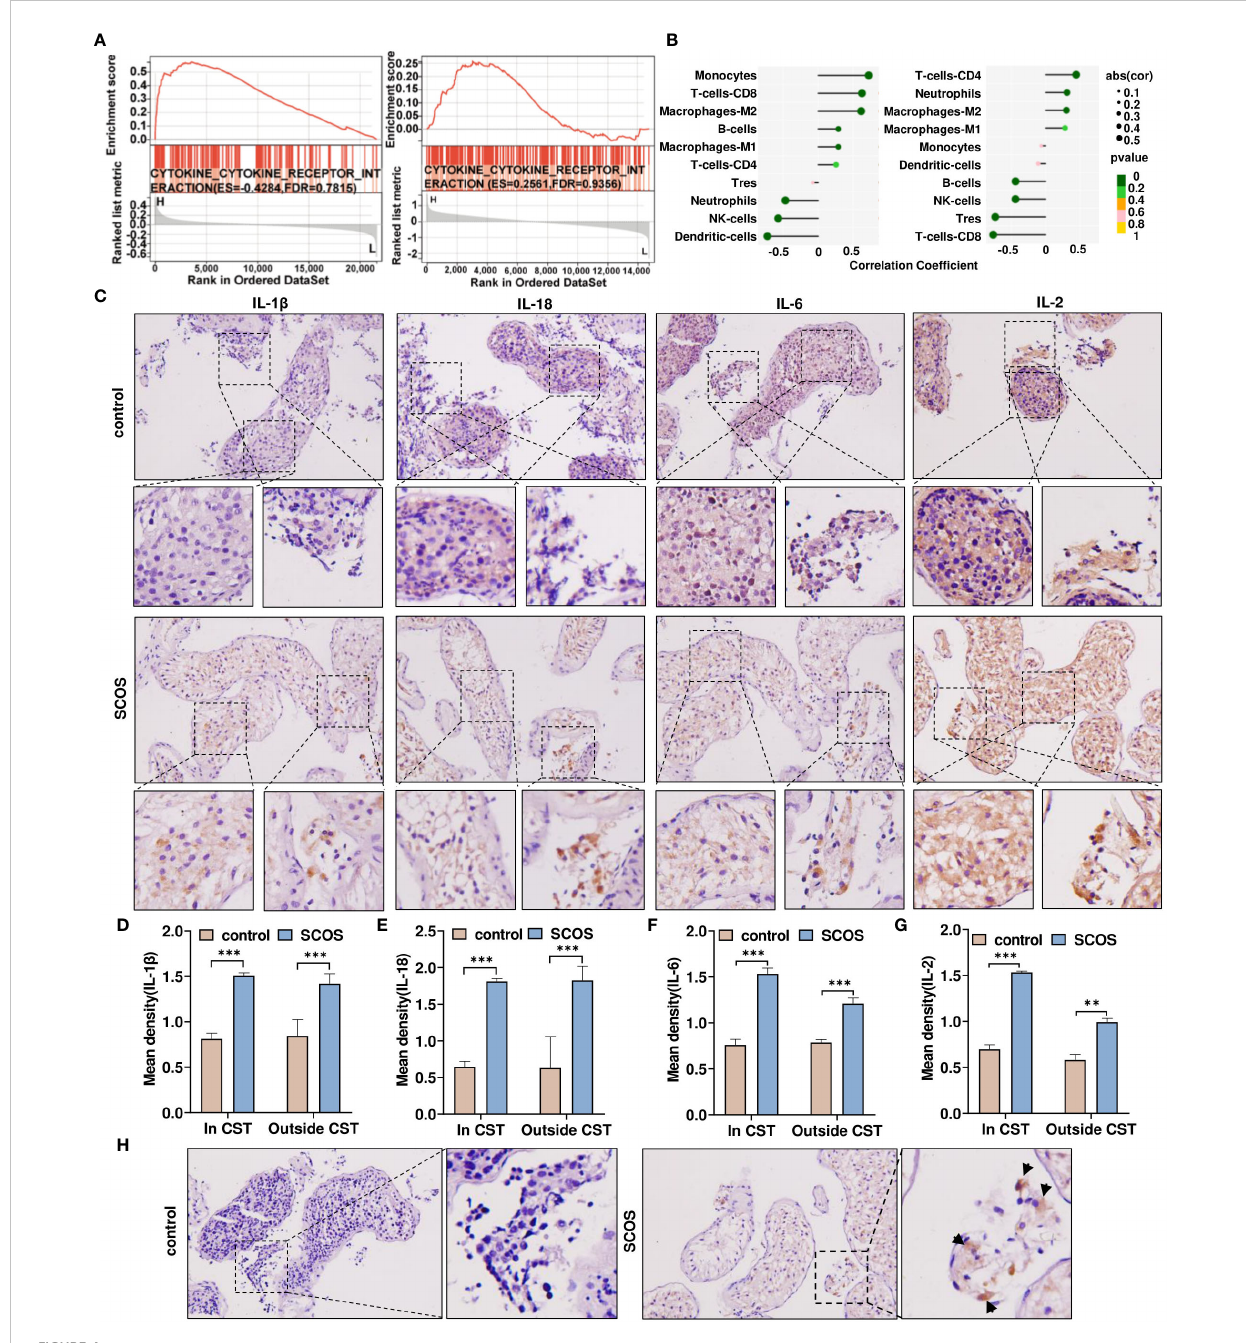
FIGURE 4 DDX58 expression is positively correlated with the intratesticular in fl ammatory response of SCOS. (A) GSEA results of cytokine-cytokine receptor interaction pathways in two datasets were compared between the samples with high and low DDX56 expression. (B) Lollipop plots showing the correlation between the expression of DDX58 and different TIIC ratios analyzed using quanTIseq and CIBERSORT. (C) Immunohistochemical staining of IL-1 b , IL-18, IL-6, and IL-2 in testes with OA and SCOS. Scale bar: 50 m m. Original magni fi cation: ×200 (n= 10). (D – G) Average IL-1 b , IL-18, IL-6, and IL-2 staining intensities in and outside the CST. **p < 0.01, ***p < 0.001 vs . the control group. (H) Results of macrophage immunohistochemical staining in SCOS and OA testis tissues marked with F4/80 antibodies. Scale bar: 50 m m. Magni fi cation: